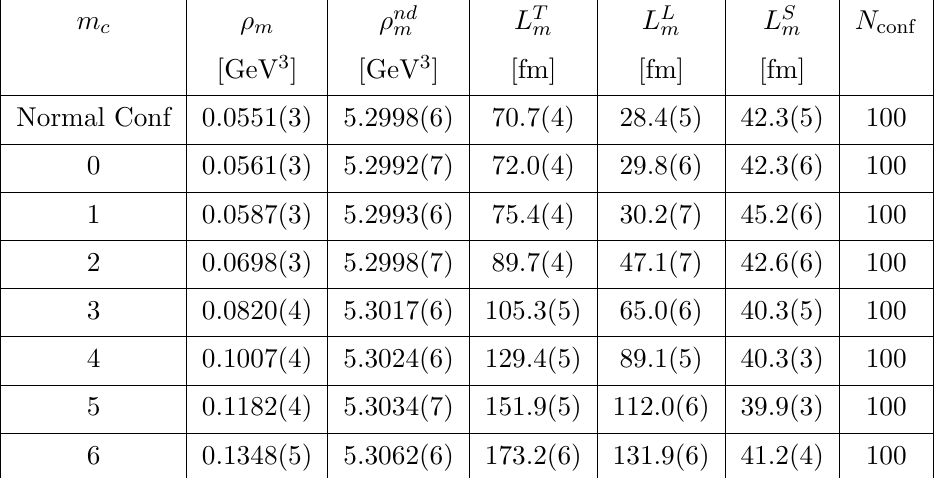
Table 3 . The computed results of the monopole densities (cid:26) m and (cid:26) nd monopole loops L T